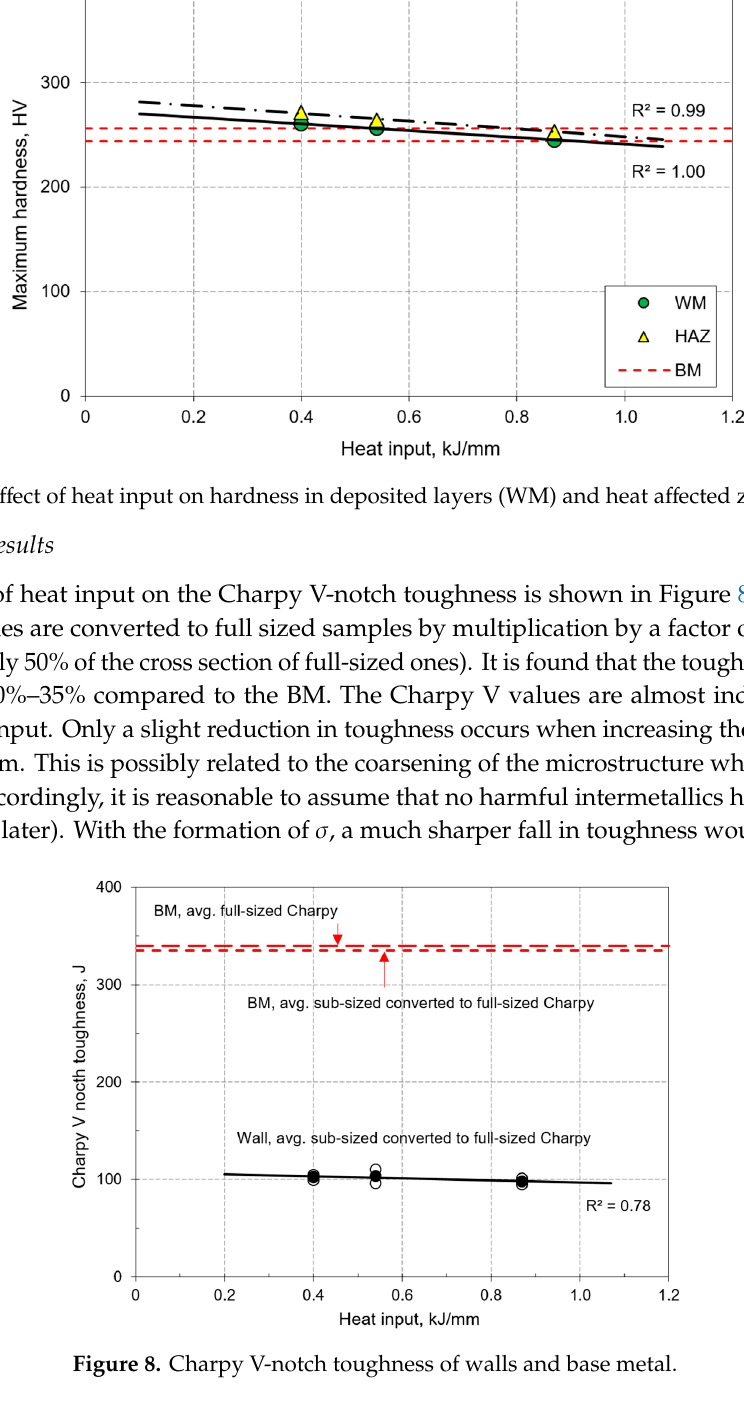
Figure 9. CTOD fracture toughness of walls. 3.5. Solidification Stainless steel may solidify in different modes according to their chemical composition. In addition, the cooling rate may induce a shift in solidification [41]. In austenitic stainless steels, a three- phase reaction region exists ( Liquid → γ + δ ), which can be either eutectic or peritectic for compositions beyond 15 wt.% Cr and 10 wt.% Ni according to the Fe-Cr-Ni ternary phase diagram [42,43]. Here, δ means the high temperature ferrite and used according to literature. Consequently, the solidification microstructure, depending on both composition and cooling rate, may become more complex due to the three-phase reaction. Depending on the Cr eq / Ni eq ratio, stainless steel can be solidified with four different solidification modes [44,45], i.e., ferrite mode, ferrite-austenite mode, austenite-ferrite mode and austenite mode (here Liq means—liquid phase of the material): F mode: Liq → Liq + δ → δ → δ + γ for Cr eq/ Ni eq > 2.0